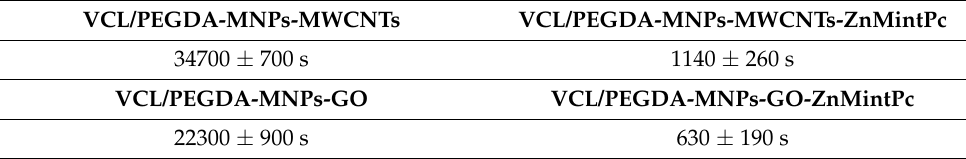
Table 3. Decay times of nanocomposites.